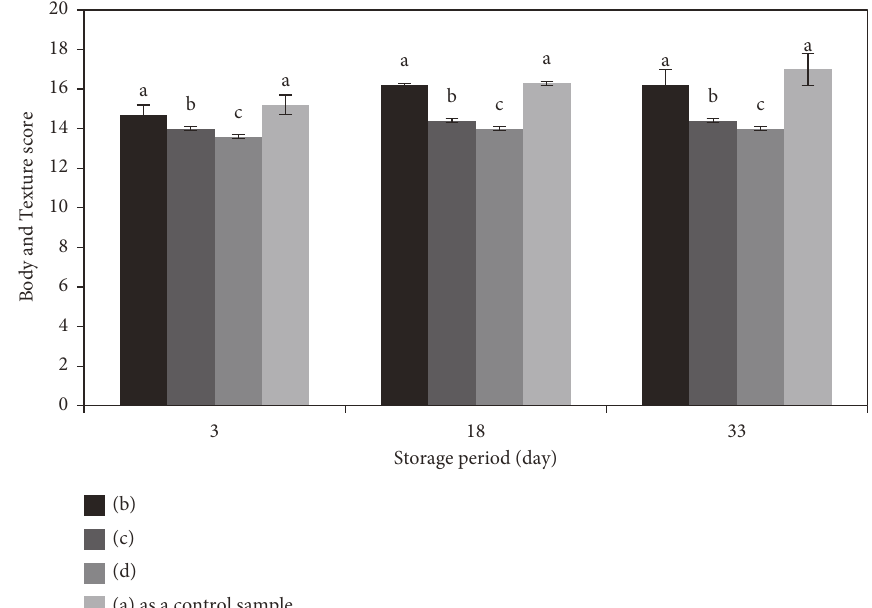
Figure 4: Changes in body and texture score of Iranian UF cheese ∗ treated by KCl and NaCl during 33days of storage period. ∗ (a) 3% NaCl (control), (b) 1.50% NaCl+1.50% KCl, (c) 1.00% NaCl+2.00% KCl, and (d) 0.75% NaCl+2.25% KCl.